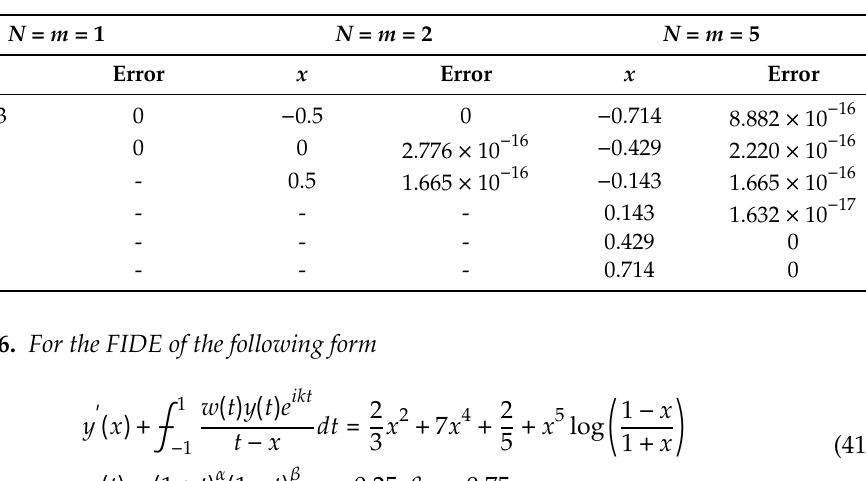
Table 6. The absolute error for N = 1,2,5.